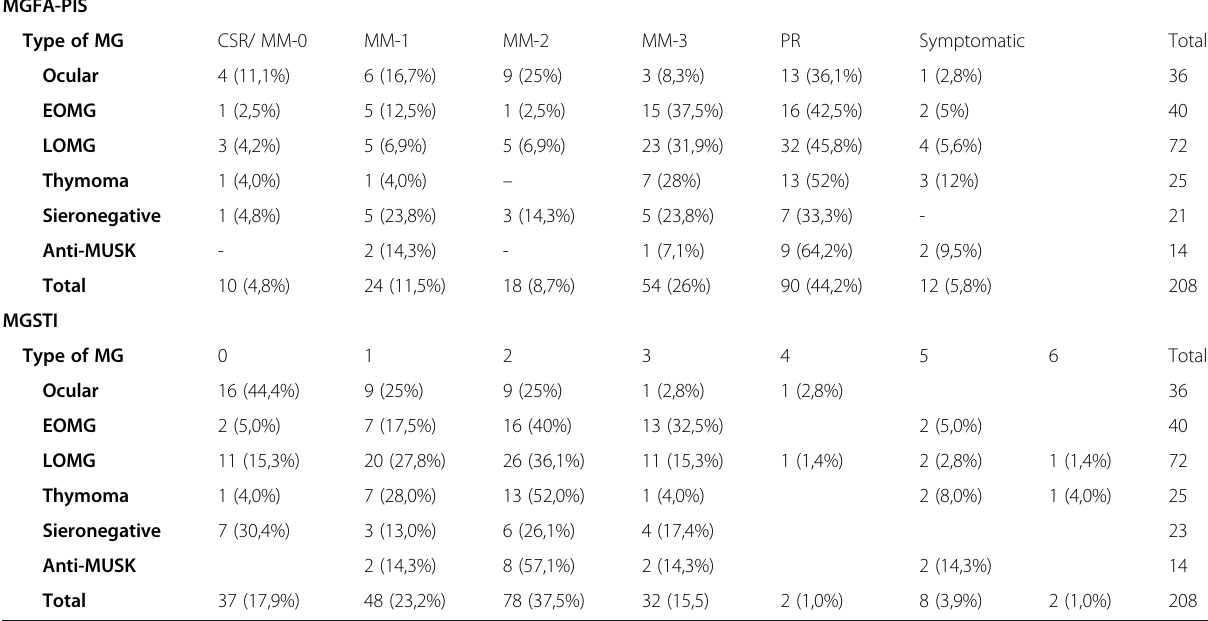
Table 2 MGFA PIS and MGSTI at last follow up MGFA-PIS Type of